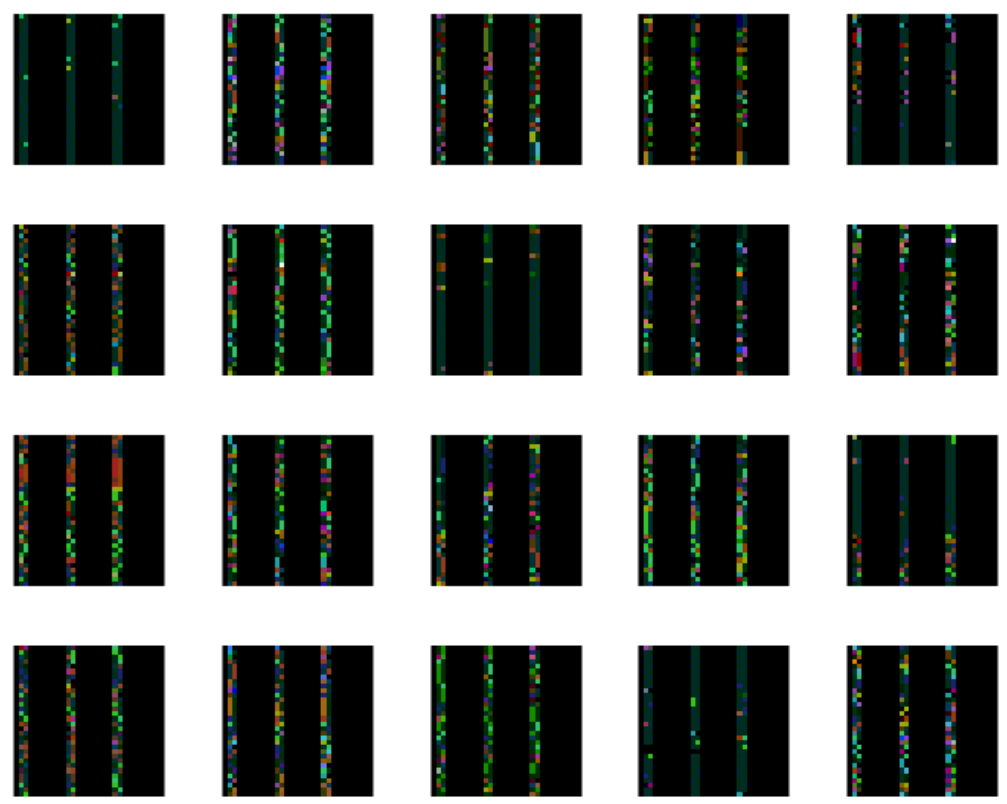
Figure 4. Example of transformed NTF records into frame images.